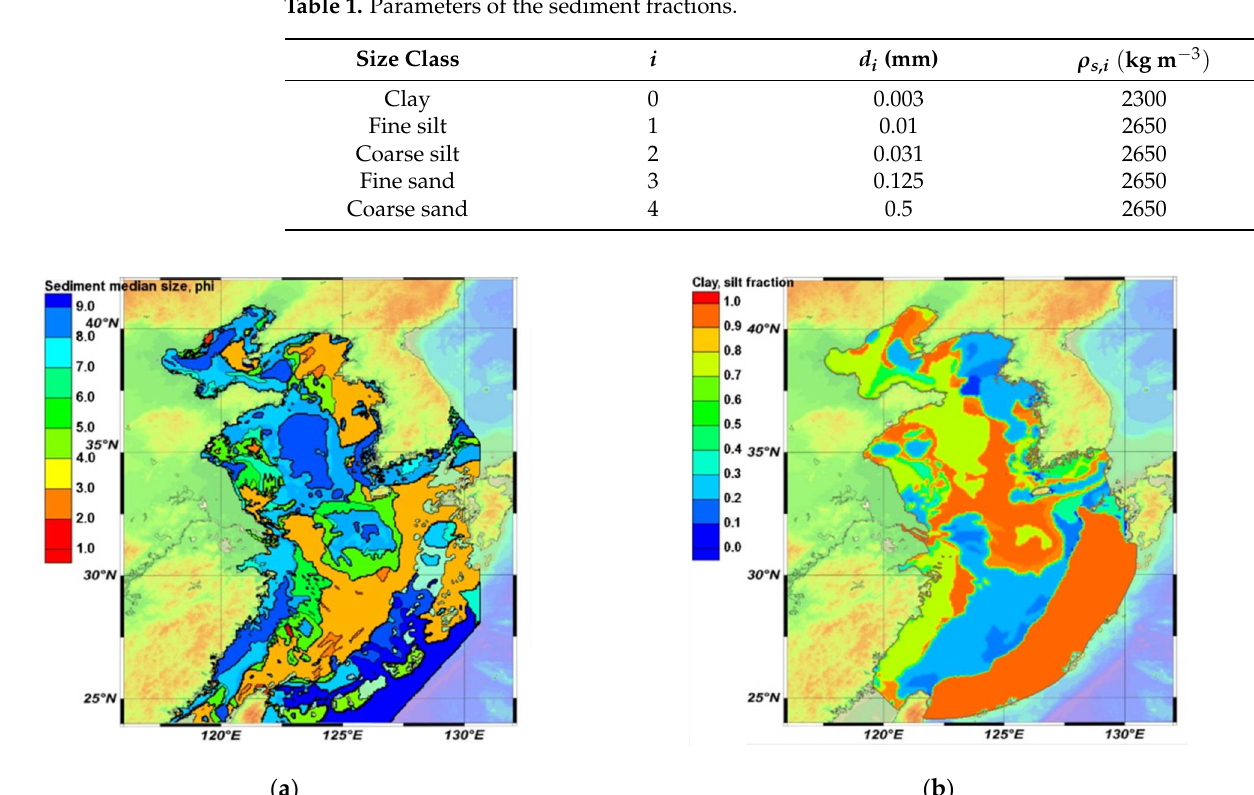
Figure 4. ( a ) Distribution of sediment median size 50 ; ( b ) distribution of mud fraction.